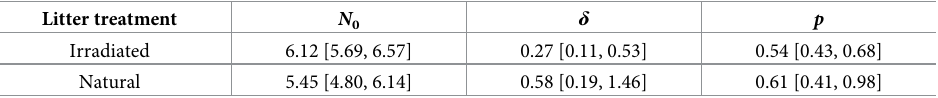
Table 3. Parameters values of the fitted Weibull models describing the survival of Salmonella Typhimurium (ST) in irradiated and natural poultry litter. Litter treatment N 0 δ p Irradiated 6.12 [5.69, 6.57] Natural 5.45 [4.80, 6.14] 0.58 [0.19, 1.46] 0.61 [0.41, 0.98] Best-fit parameter values and their 95% confidence intervals, [CI], are reported. N 0 , initial inoculum concentration (log CFU g -1 ); δ , time (days) to first decimal reduction; p , shape of inactivation